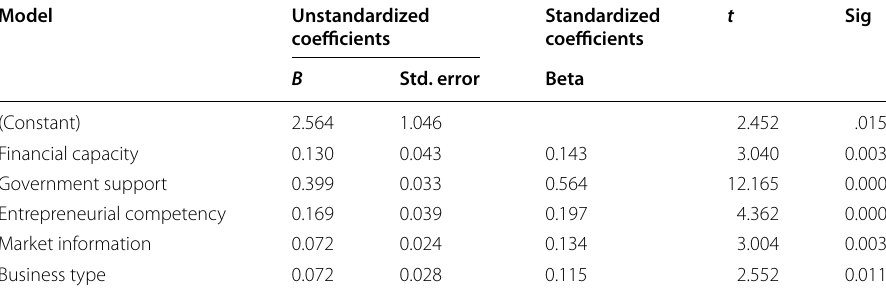
a Dependent variable: Growth of MSE